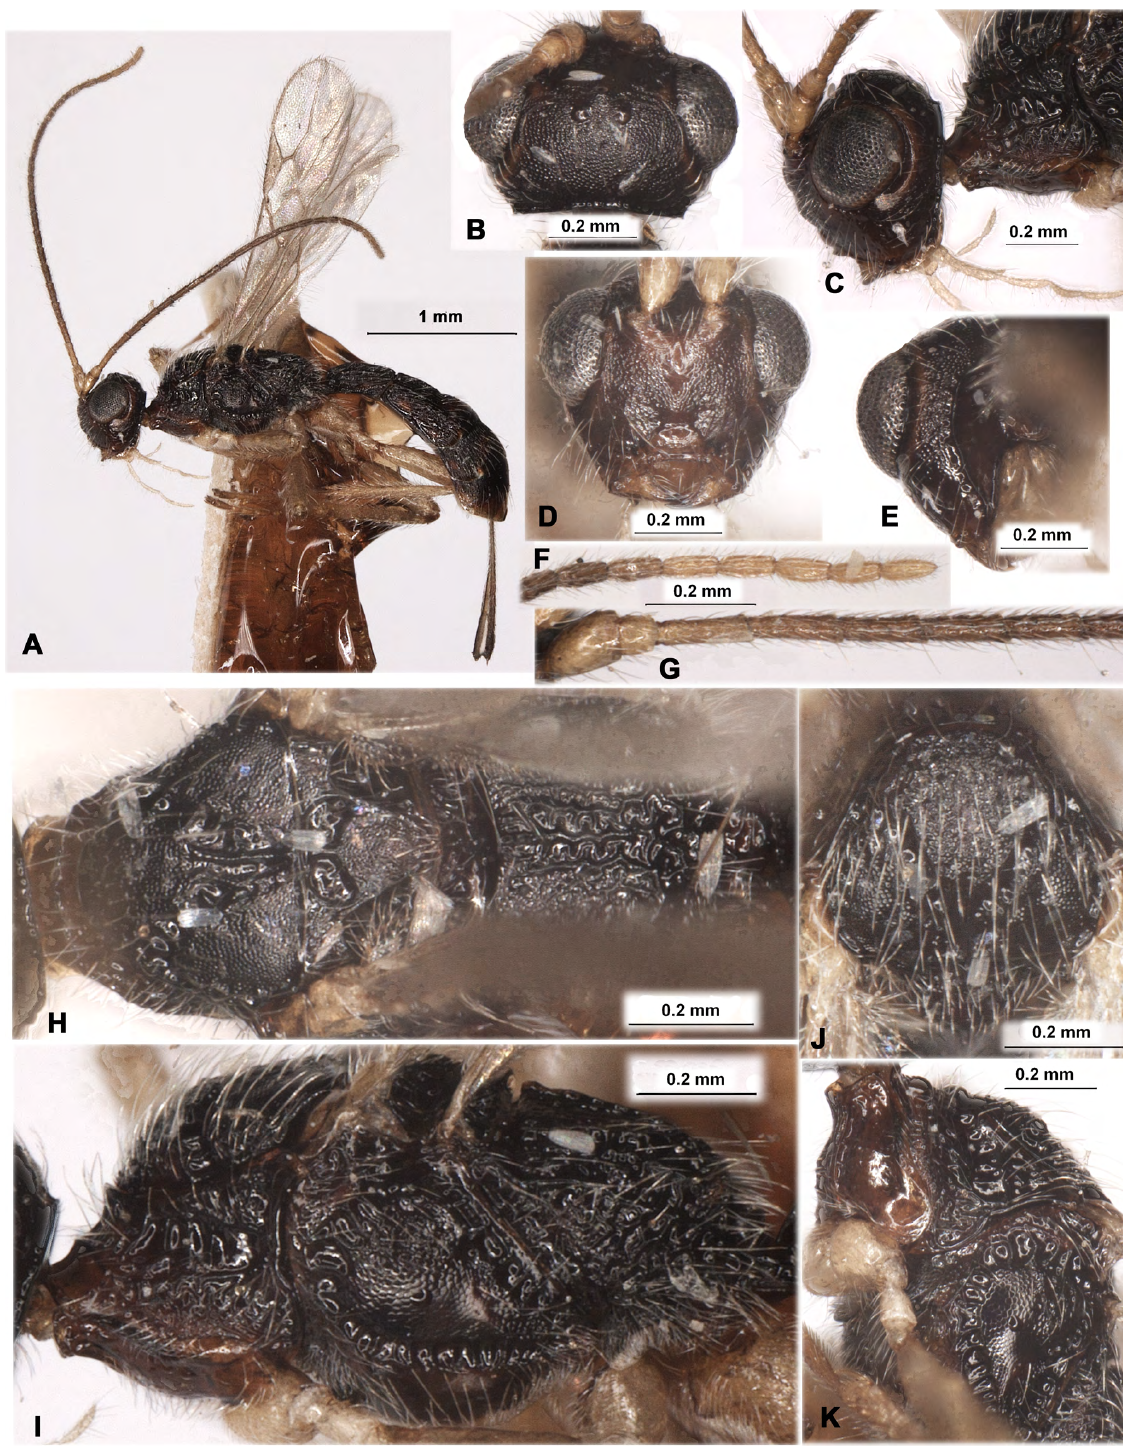
Fig. 47. Rhaconotus ( Pararhacon ) haeselbarthi Belokobylskij, 2005, ♀, holotype, SSMG. A . Habitus, lateral view. B . Head, dorsal view. C . Head, lateral view. D . Head, front view. E . Head, posterior view. F . Apical segments of antenna. G . Basal segments of antenna. H . Mesosoma, dorsal view. I . Mesosoma, lateral view. J . Mesoscutum. K . Pro-and mesopleura, lateral